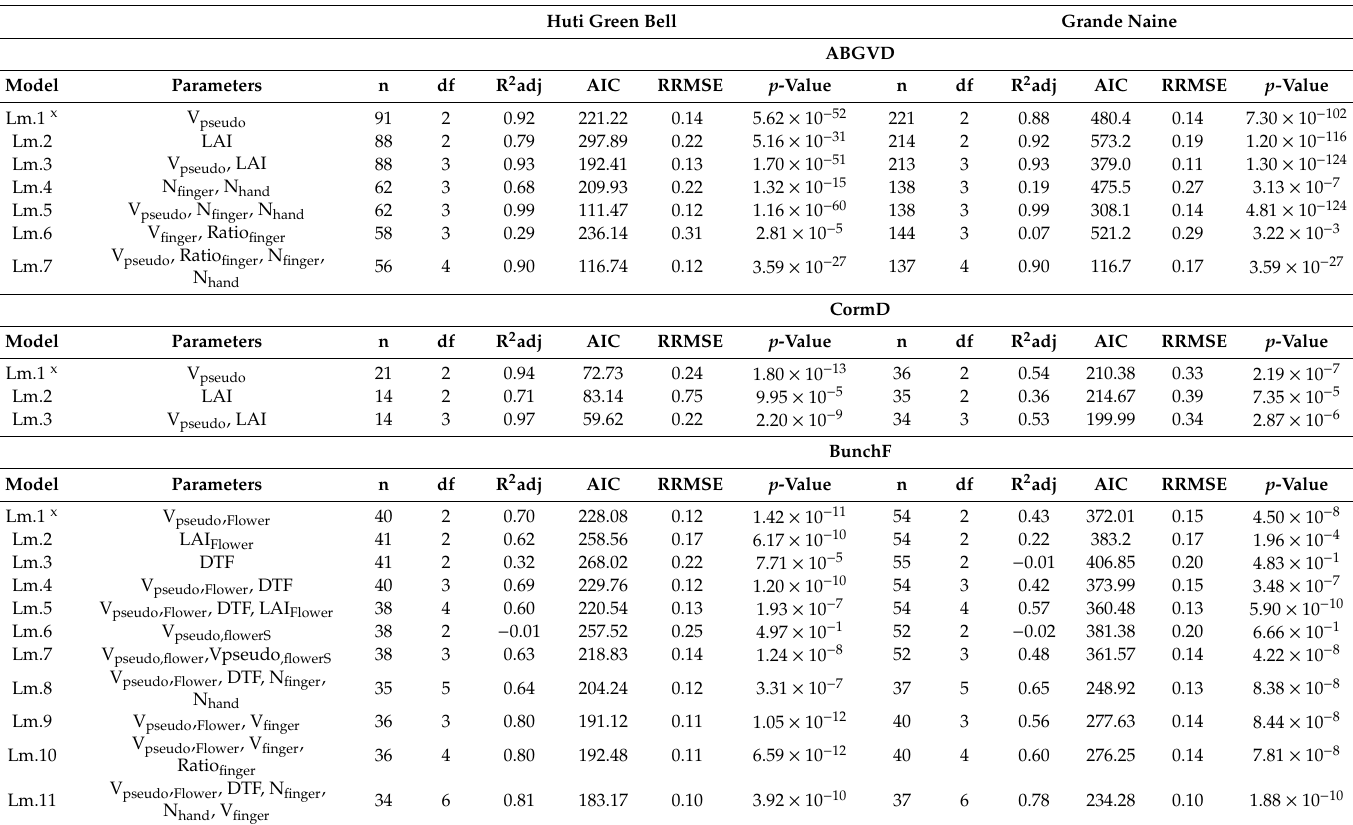
Table 4. Regression models for fully irrigated plants of Huti Green Bell and Grande Naine, with goodness of fit characteristics. Models are multiple linear regression models with each parameter ‘x’ characterized by intercept ‘a’ and slope ‘b’: y = a + b × x. ABGVD notes the aboveground vegetative dry biomass (leaves, petioles, and pseudostem), cormD notes the corm dry biomass, and bunchF notes the fresh bunch weight. Additional parameters are explained in Table 1 and given underneath the